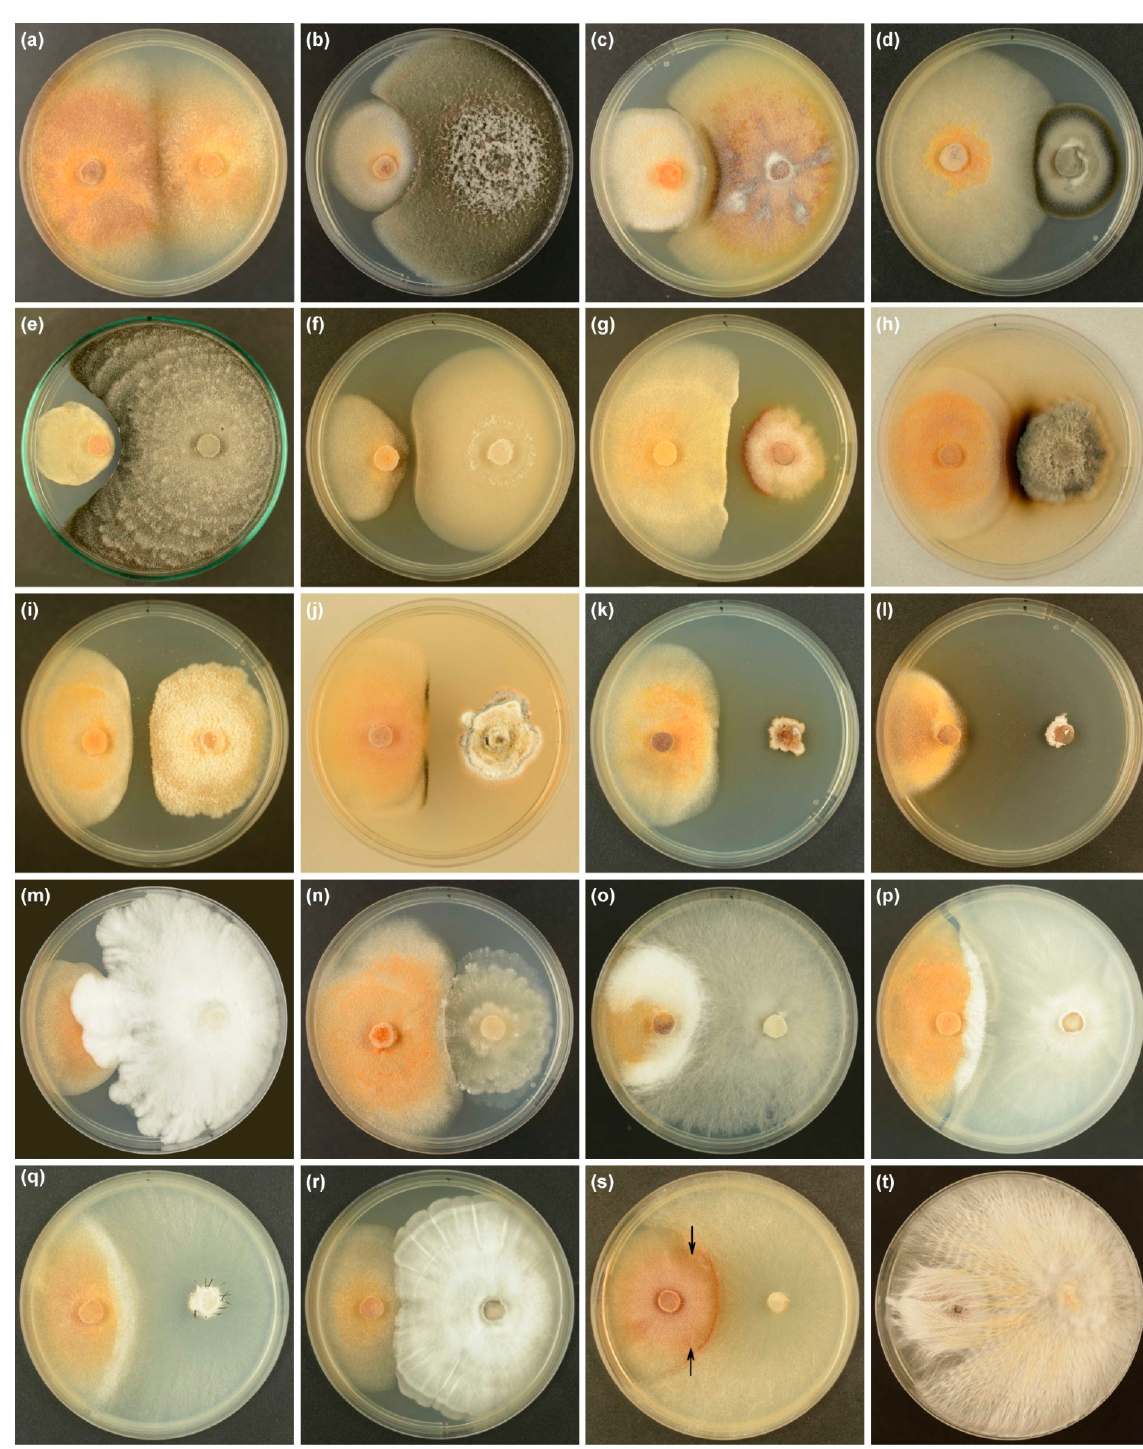
Figure 9. Various types of interactions observed in dual cultures (MEA, 3 weeks, 20 °C), Hymenoscyphus fraxineus (Hf1 or Hf2) from the left, test fungus on the right: ( a – d ) type A interaction, ( a ) Hymenoscyphus fraxineus (FeF164), ( b ) Alternaria sp. 1 (FeF152), ( c ) Microsphaeropsis sp. (FeF92b), ( d ) Pyrenochaeta sp. (FeF13), ( e – l ) type B interaction, ( e ) Phacidium lacerum (FeF246), ( f ) Plectosphaerella cucumerina (FeF161b), ( g ) Hypoderma rubi (FeF203), ( h ) Pleospora sp. (FeF80), ( i ) Paraphaeosphaeria neglecta FeF109), ( j ) Lanzia sp. (FeF26), ( k ) Malbranchea sp. (FeF243), ( l ) Pseudocoleophoma polygonicola (FeF201), ( m – t ) type C interaction, ( m ) Nemania diffusa (FeF104), ( n ) Nemania serpens (FeF245), ( o ) Rosellinia corticium (FeF167), ( p ) Rosellinia nectrioides (FeF187) (with inhibition zone only partly covered, see text), ( q ) Xylaria sp. 1 (FeF97a), ( r ) Xylaria polymorpha (FeF30), ( s ) Desmazierella acicola FeF119, ( t ) Hypholoma fasciculare